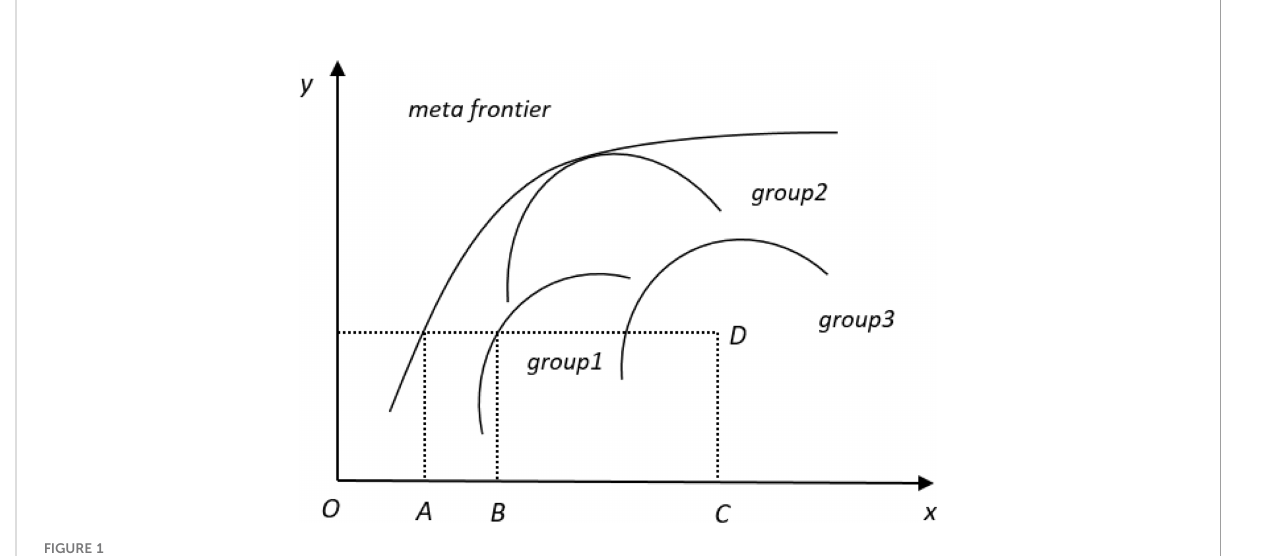
FIGURE 1 Meta-frontier curve and group-frontier